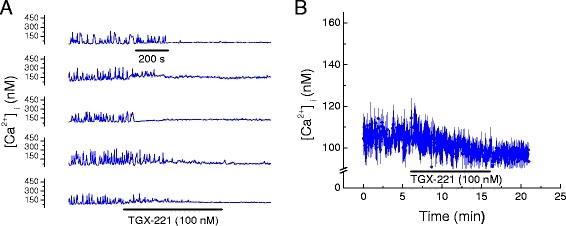
Pharmacologic inhibition of phosphoinositide-3-kinase (PI3K) isoform β decreased Ca
2+
, [Ca
2+
]
i
, in HL-1 cell mouse cardiomyocytes.
A
. Effect of TGX-221 (100 nM) on [Ca2+]i oscillations in five representative HL-1 cells. Time base applies to all traces.
B
. Effect of TGX-221 (100 nM) on average [Ca2+]i in cells displaying oscillating and non-oscillating [Ca2+]i (mean ± SEM; n = 5, each an average of 25 to 40 cells as shown in A).